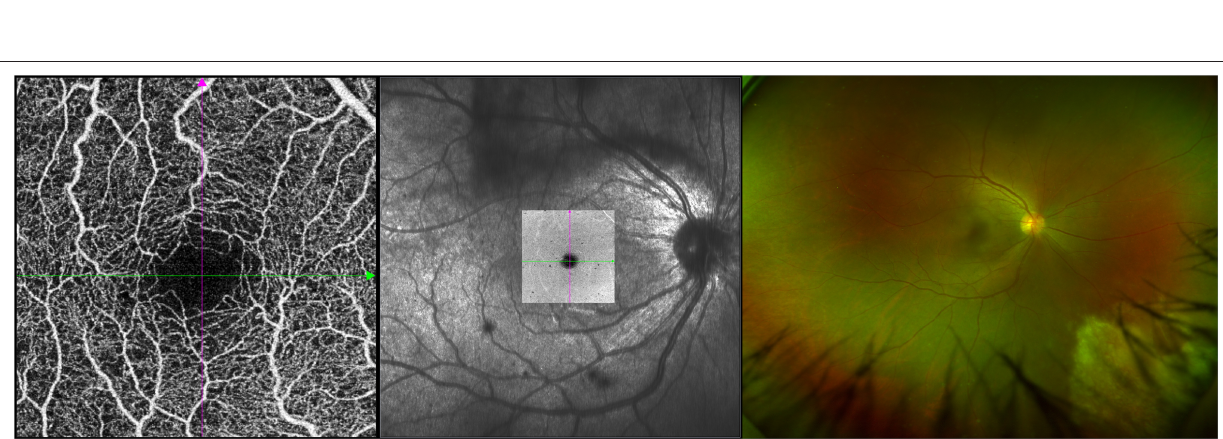
Frontiers in Medicine |